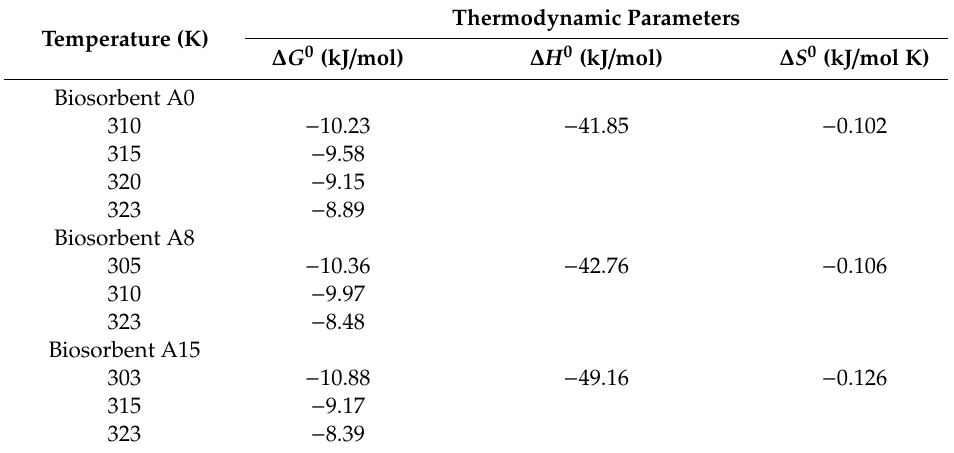
Table 5. The thermodynamic parameters of Cd 2 + sorption using three types of biosorbent of Aphanothece sp. (C 0 = 8 mg / L, pH = 8, W 0 = 0.1 g / L, t contact = 60 min). Thermodynamic Parameters Temperature (K) ∆ G 0 (kJ /